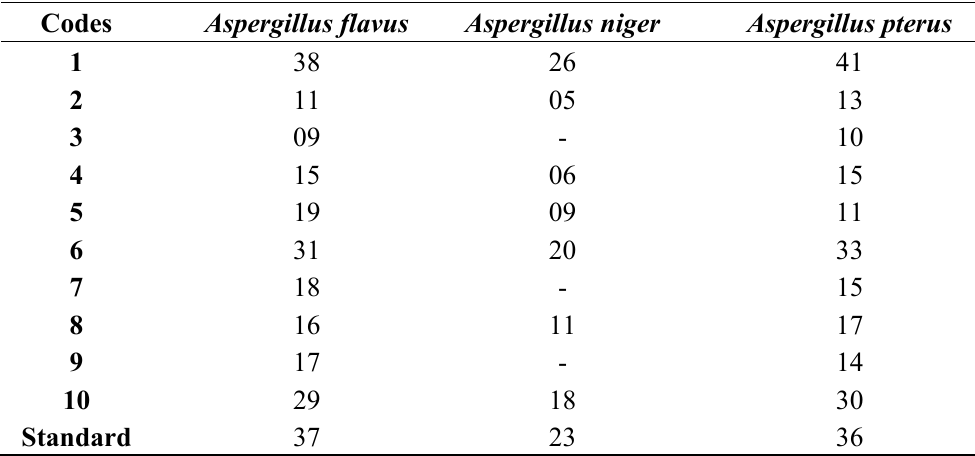
Table 3. Antifungal bioassay screening of tertiary alcohols 1-10